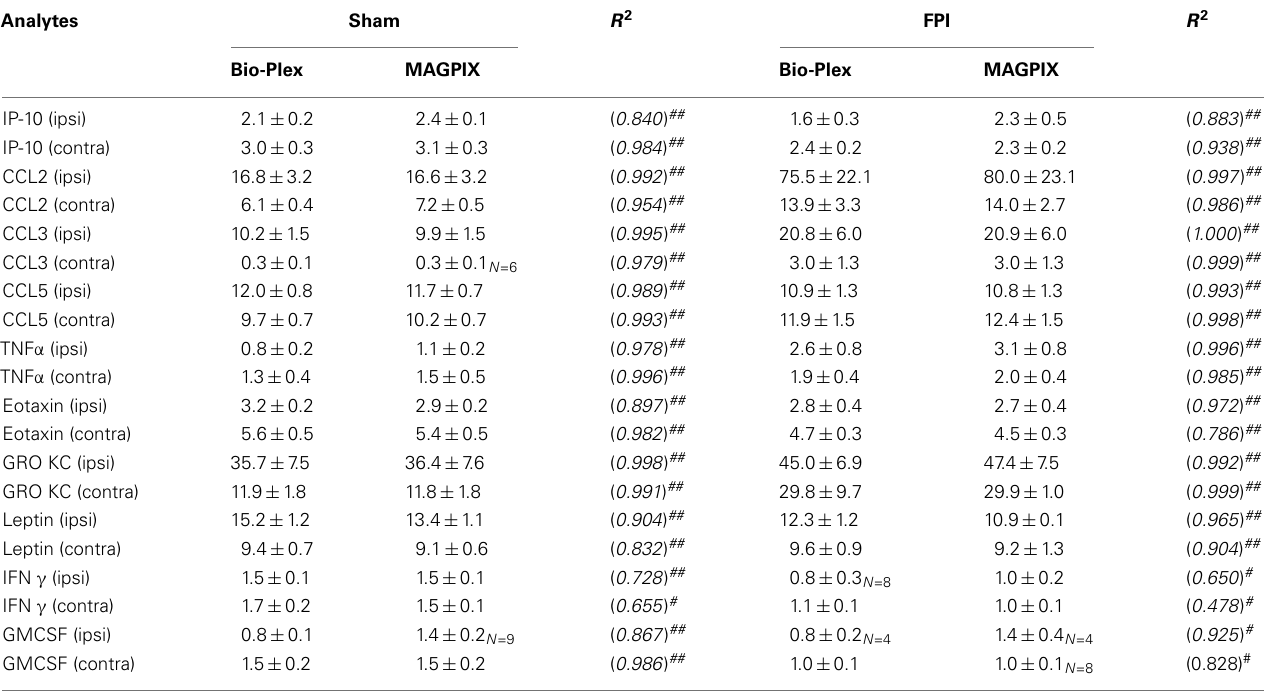
Table 3 | Comparison of the level of analytes in the cortex detected by Bio-Plex vs. MAGPIX 24h after FPI. Analytes Sham